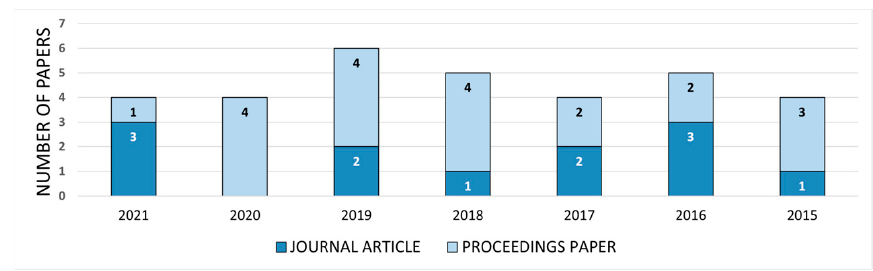
Figure 2. Distribution of publications by published year and type of publication.